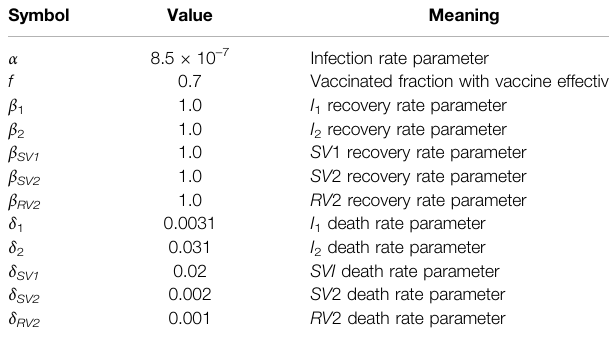
TABLE 3 | Parameters of the model.